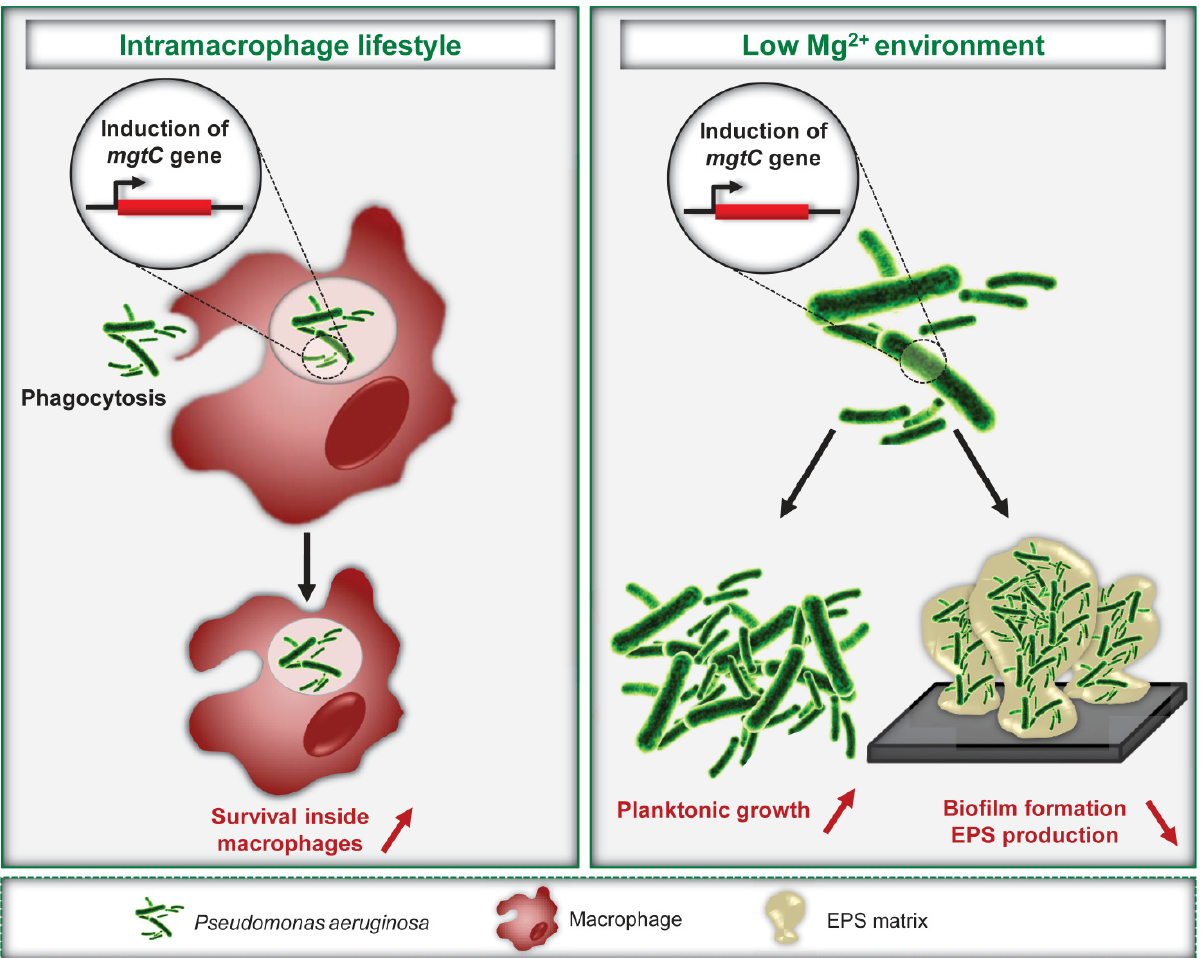
FIGURE 1 : P. aeruginosa MgtC promotes an intramacrophage phase and limits biofilm formation . Expression of P. aeruginosa mgtC gene is induced inside macrophages and in magnesium-deprived medium. P. aeruginosa MgtC is involved in resistance to macrophage, a feature shared with MgtC proteins from intracellular pathogens as S. Typhimurium. Under magnesium deprivation, MgtC promotes planktonic growth but limits biofilm formation and EPS